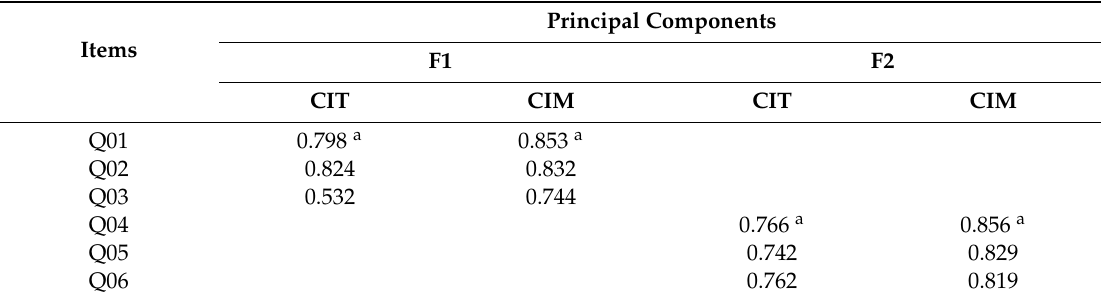
Table 13. Principal components analysis of the factors related to work design (F1) and work development (F2).